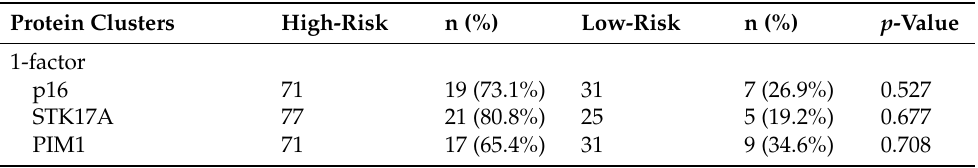
Table 3. The proportion of disease-progressed in each protein cluster derived by the unsupervised hierarchical clustering